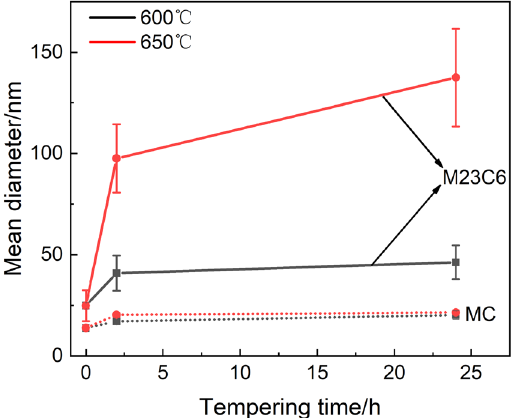
Figure 11: Evolution of main carbide size for 5CrNiMoVNb steel with tempering temperature and tempering time.